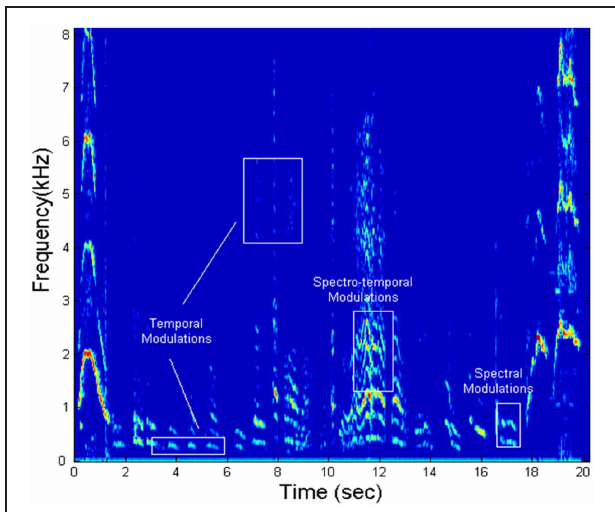
FIGURE 1 | Representative spectrogram of vocalizations in a toddler’s speech sample, demonstrating spectro-temporal modulations.